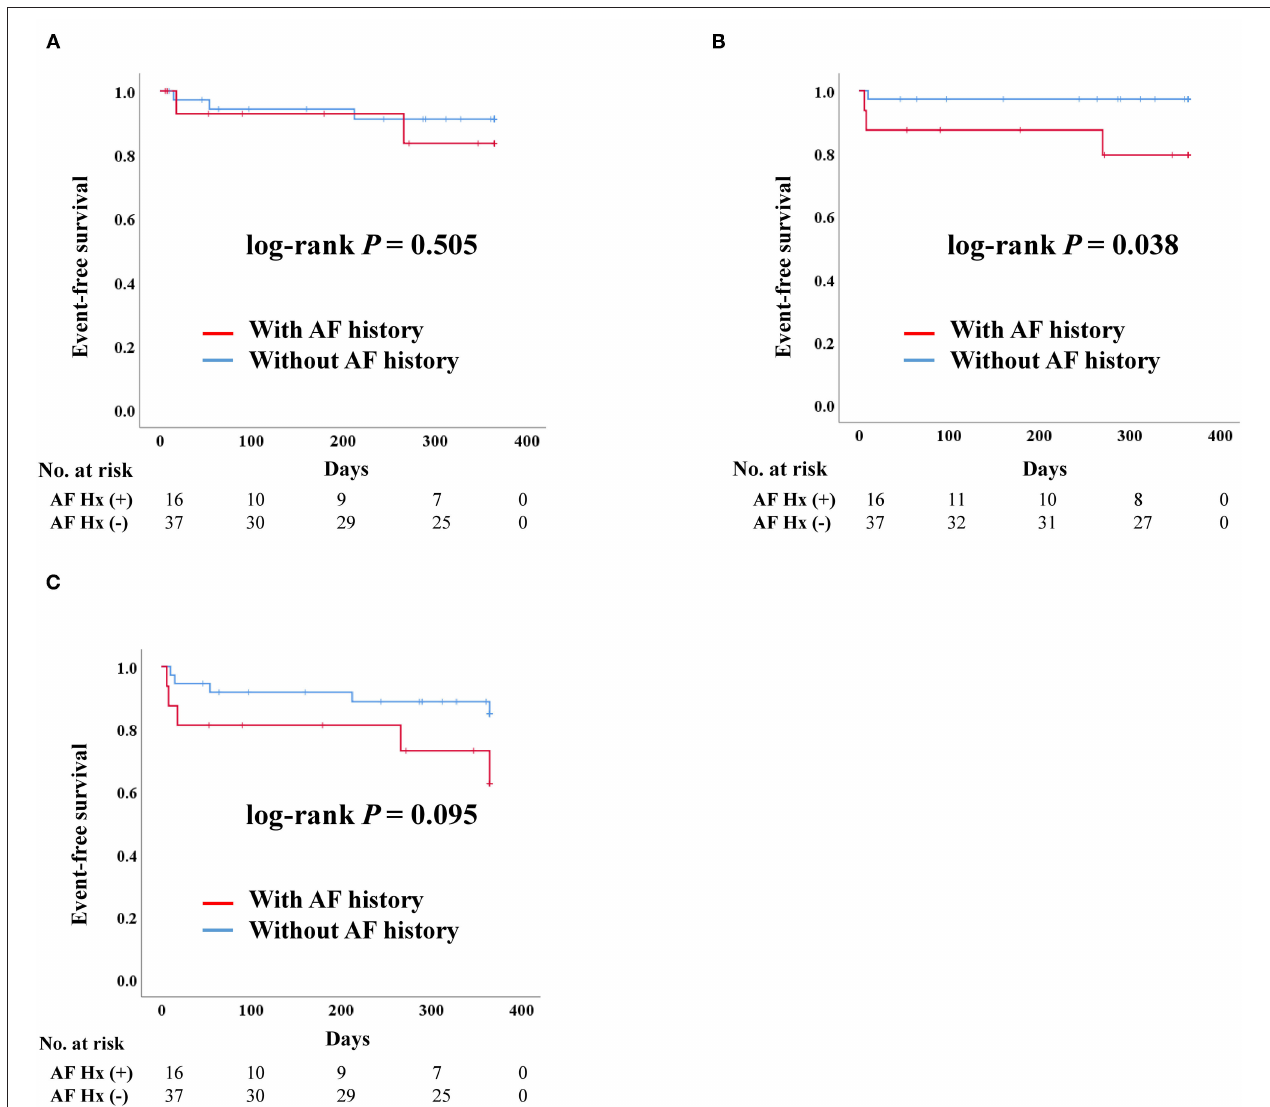
FIGURE 3 | Clinical outcomes of surgical aortic replacement (SAVR) according to previous history of atrial fibrillation after propensity score matching. AF, Atrial fibrillation; Hx, History; Composite outcome, Composition of admission due to heart failure, stroke, or death. (A) Admission due to heart failure. (B) Death. (C) Composite